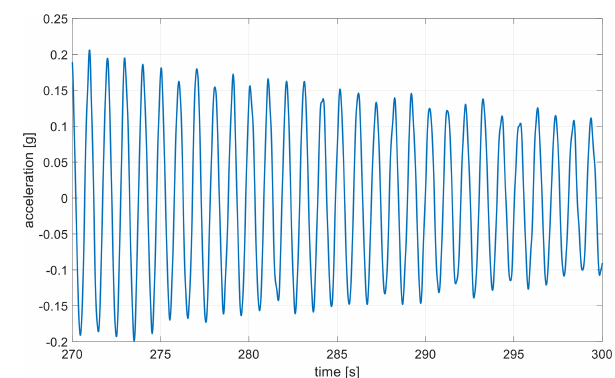
Figure 6. Free decay as measured by nacelle accelerometers.